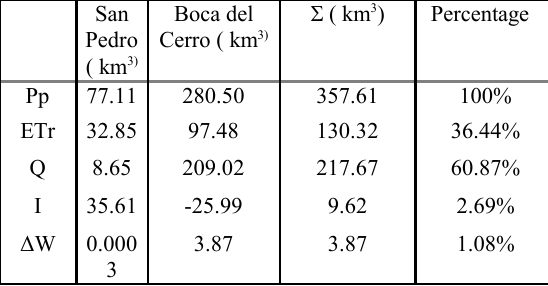
Table 1. Summary of the water balance of the 36 monthly periods by